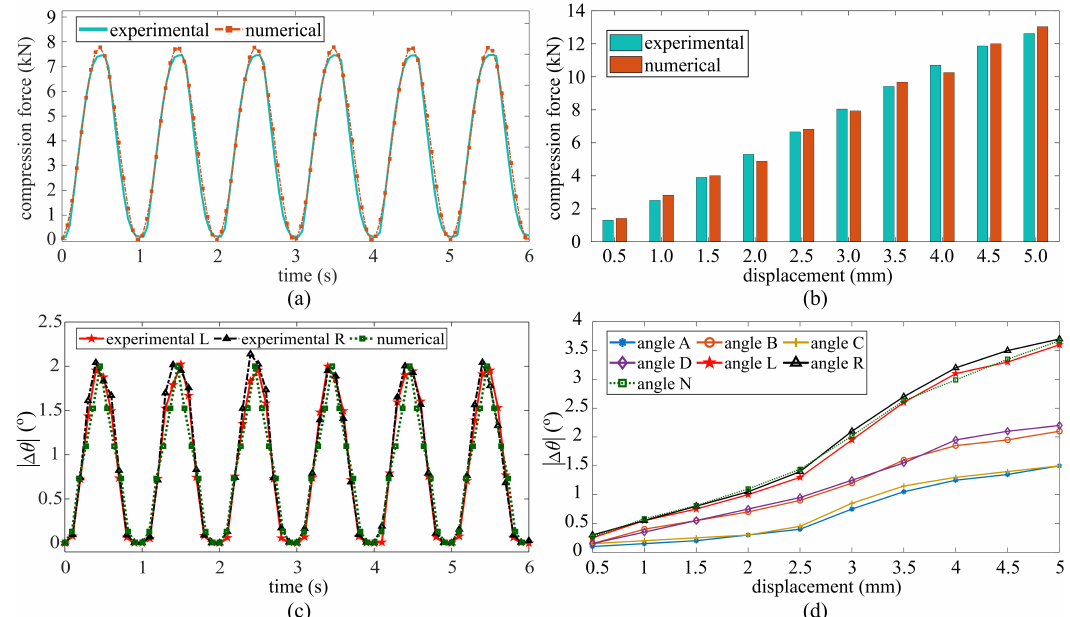
Figure 7. Comparison of the compression forces obtained numerically and experimentally: ( a ) time series under a 3.0 mm maximum displacement amplitude, and ( b ) average maximum compression force under each maximum displacement amplitude; ( c ) comparison of angular rotation ( ∆ θ i ) under a 3.0 mm maximum displacement amplitude; ( d ) absolute values of angular rotations ( ∆ θ i ) as a function of applied